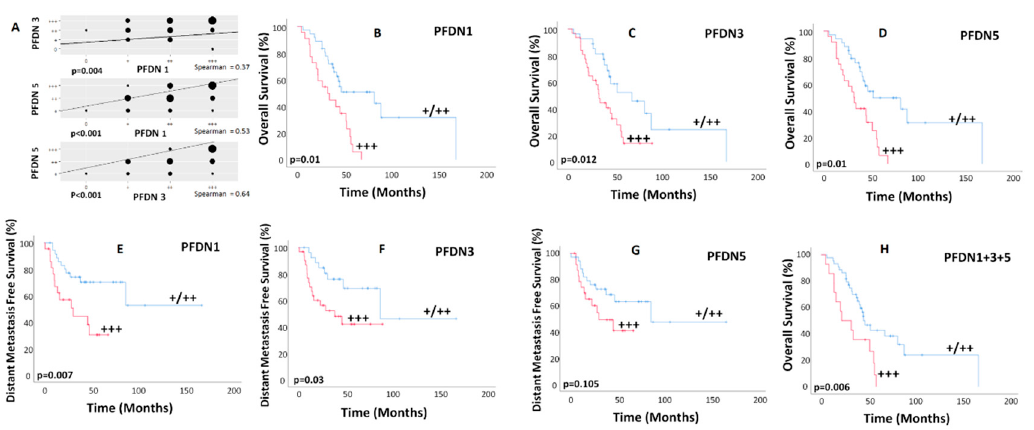
Figure 2. ( A ) Correlation among PFDN protein levels for all 58 patients. The diameter of the dots is proportional to the number of cases. ( B – H ) Kaplan–Meier curves for overall survival ( B – D ) and distant metastasis-free survival ( E – G ) according to PFDN expression and overall survival when combining all overexpressed PFDNs ( H ).